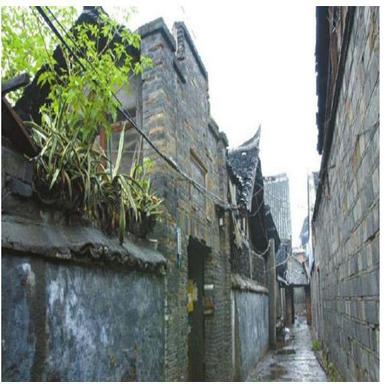
Traditional masonry buildings constructed with GCB in China.